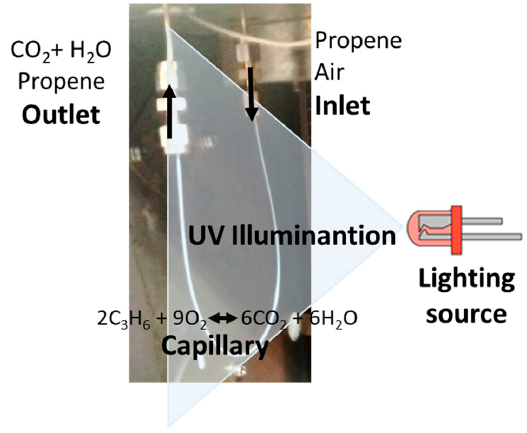
Figure 1. Illustration of the experimental set up used for photocatalytic oxidation of VOCs.